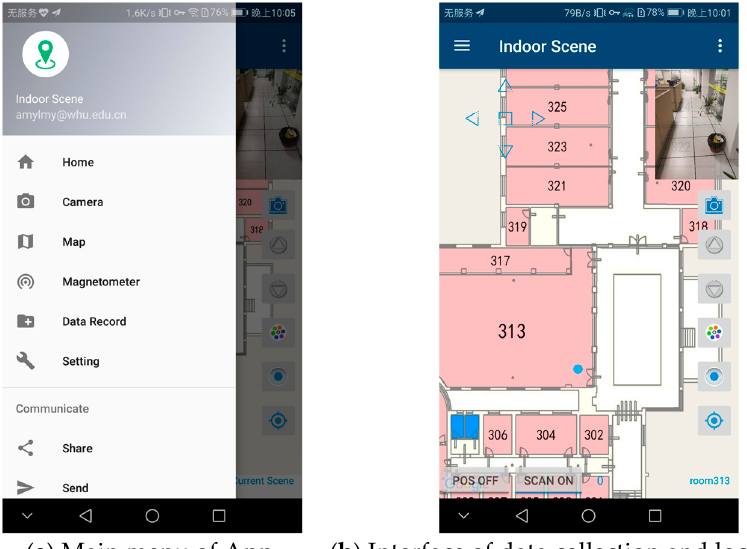
Figure 10. Interface of the proposed system on an Android phone. Before data recording start, we need to switch off the positioning mode, choose a current scene label and pick a start point on the map. Then, after switching on the scan mode, data recording will be activated.